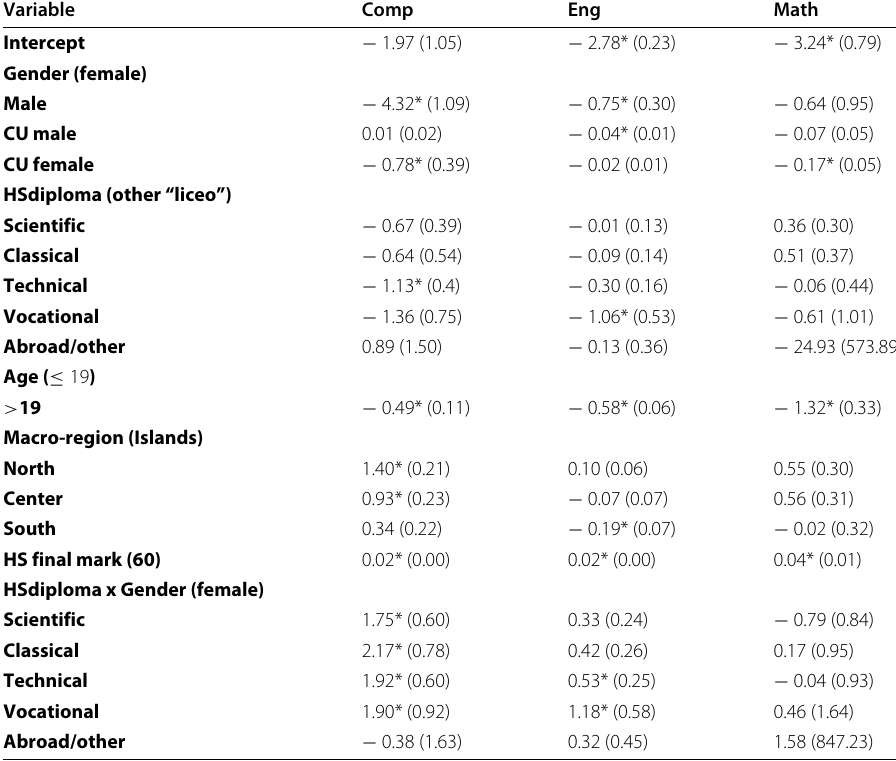
Table 6 Parameter estimates θ ’s of the segmented regression models by degree course Variable Comp Eng